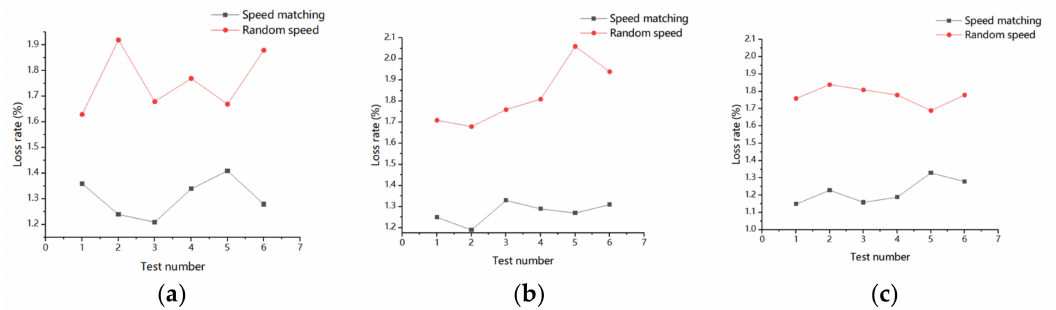
Figure 17. Comparison of loss rates of three crops under two conditions. ( a ) Rice experiment; ( b ) Rape experiment; ( c ) Millet experiment.